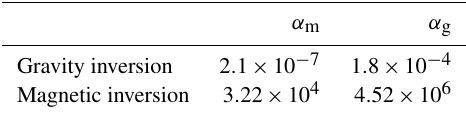
Table 1. Optimum values of ( α m , α g ) estimated from L-surface